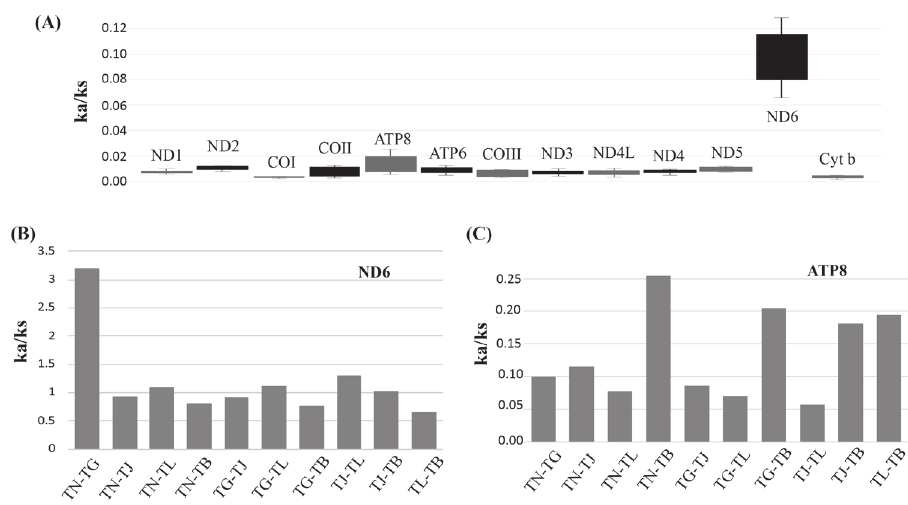
Figure 7. A Mean evolutionary rates for each protein coding gene in mitogenomes of five Trichiurus species B Evolutionary rates of ND6 gene of five Trichiurus species. C Evolutionary rates of Ka/Ks in ATP8 gene of five Trichiurus species. Indicated the rates of non-synonymous substitutions to the rate of synonymous substitutions (ka/ks). T. japonicus (TJ), T. lepturus (TL), T. nanhaiensis (TN), T. gangeticus (TG) and T. brevis